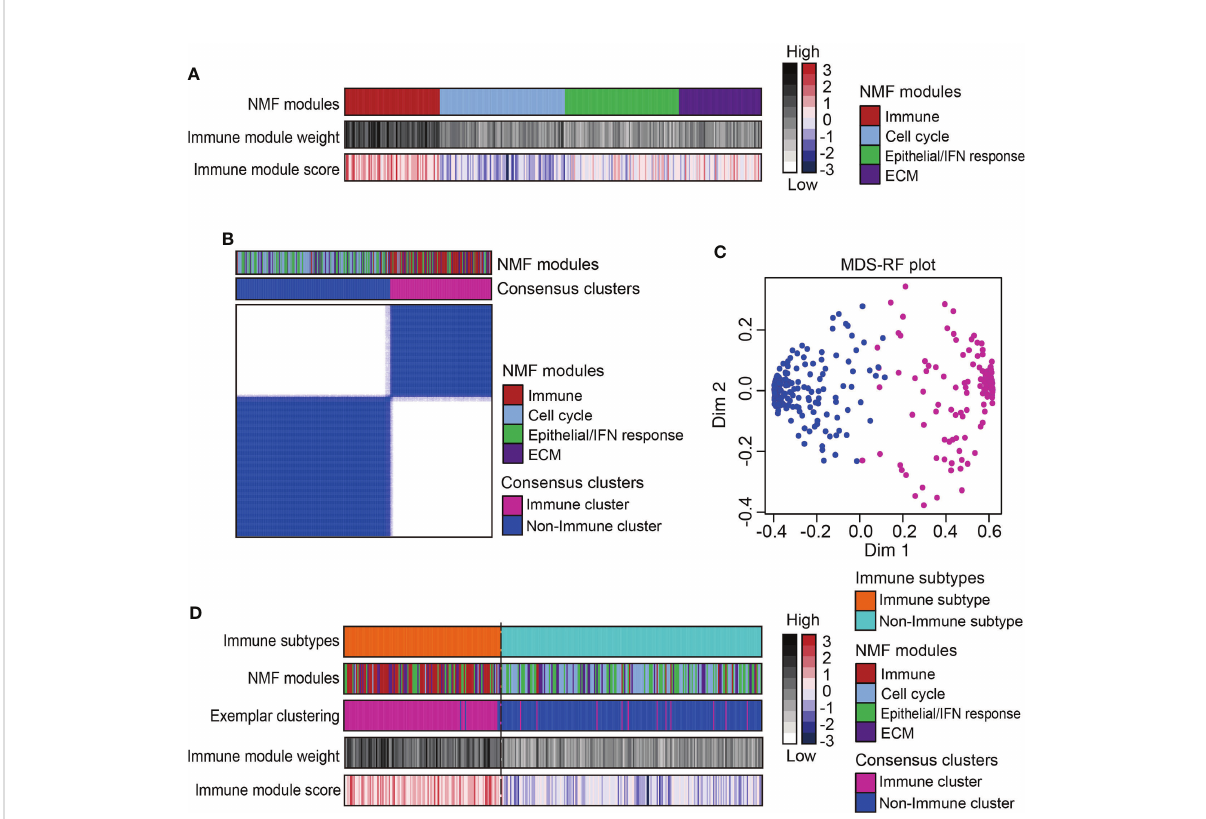
FIGURE 1 Identi fi cation of immune subtype for an integrated large-sample MPM cohort. (A) Non-negative matrix factorization (NMF) algorithms identi fi ed four functional expression modules to classify the microarray-based expression pro fi les of 333 MPM samples. One expression module showed the highest immune enrichment score and NMF module weight was marked red and recognized as an immune-associated subtype. IFN, Interferon; ECM, Extracellular matrix. (B) Consensus clustering based on the top 200 exemplar genes expression identi fi ed two subclasses with one subclass presenting enrichment of immune-related NMF module. (C) The multidimensional scaling random forest (MDS-RF) re fi ned the classi fi cation and divided whole MPM samples into immune and non-immune subtypes. (D) Heatmap shows the fi nal classi fi cation results along with various NMF modules, exemplar clustering subtypes, immune module weight, and immune enrichment